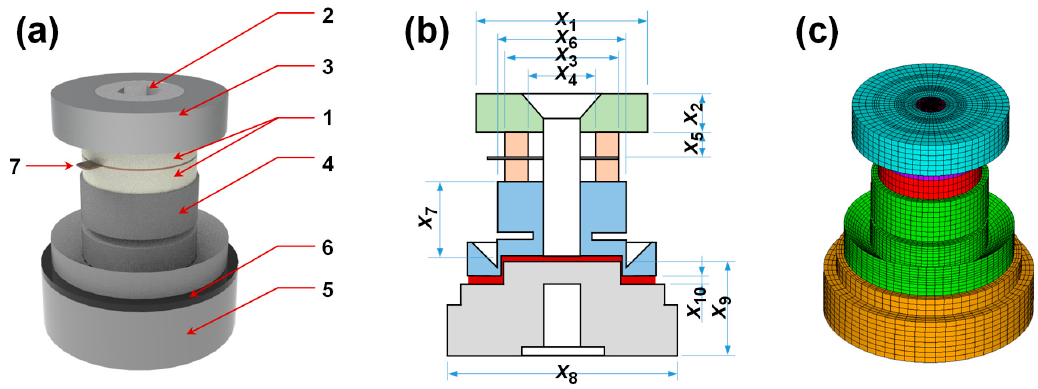
Figure 1. ( a ) Three-dimensional image of compression-type piezoelectric accelerometer module and constituent components (1: Piezo element; 2: Bolt; 3: Head (seismic mass); 4: Tail; 5: Base; 6: Insulating layer; 7: Electrode); ( b ) Ten design variables ( x 1 to x 10 ) used for numerical analysis; ( c ) Finite element model of compression-type accelerometer.